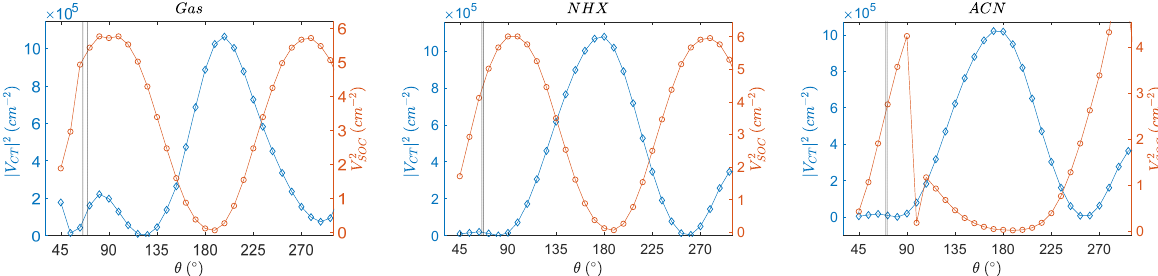
Table 6. The spin–orbit and electronic coupling at the optimized geometries. The value of the max- imum SOC value near an orthogonal geometry and the maximum electronic coupling near 180°. Figure 11. The conformational dependence of the electronic coupling and the SOCME for the singlet charge transfer state. The V SOC and V CT curves show complementary behavior. The black vertical lines are the dihedral angles at the optimized S 1 and S 2 geometry.